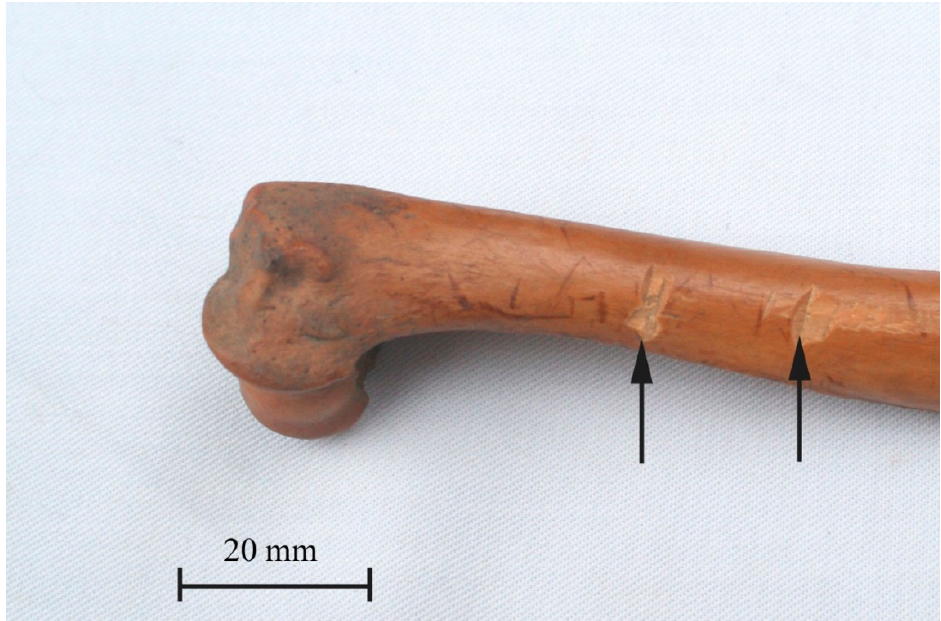
Figure 5. The humerus of dog with visible cut-marks, Wrocław-Nowy Targ site according to [16]. Reproduced with permission from A. Chrószcz, Wratislavia Antiqua; published by Instytut Archeologii UWr, 2018.